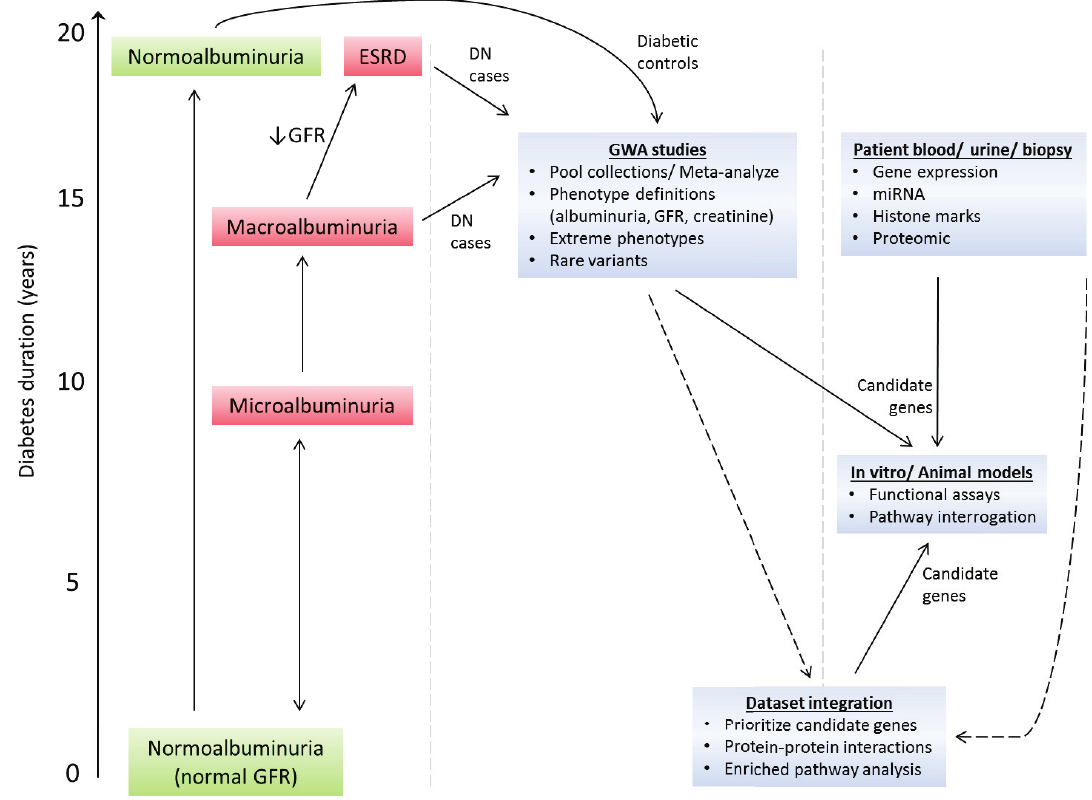
Figure 2. Unravelling the genetic and molecular mechanisms that cause DN development and progression. The clinical course of DN is relatively well defined. Diagnosis of DN is complicated by the fact that: ( a ) patients with microalbuminuria may undergo spontaneous regression to normoalbuminuria; and ( b ) glomerular filtration rate (GFR) and albuminuria may progress independently of each other, i.e. , patients may have micro- or macro-albuminuria even though their GFR is normal. Macroalbuminuria is usually associated with reduced GFR. Large scale genome-wide association (GWA) studies in DN are now feasible — future direction will require merging of patient cohorts, use of alternative phenotype definitions to the standard albumin excretion rate definition (e.g., estimated GFR, serum creatinine), analysis of extreme phenotype cohorts, and rare-variant GWA studies. To prioritize candidate genes from GWA studies in DN, these datasets will be integrated with whole-genome expression, proteomic, micro-RNA and epigenomic markers datasets using newly developed integrative tools to merge such datasets. As prioritized candidate genes are identified, functional analysis of these genes will be performed in established cell and animal models of